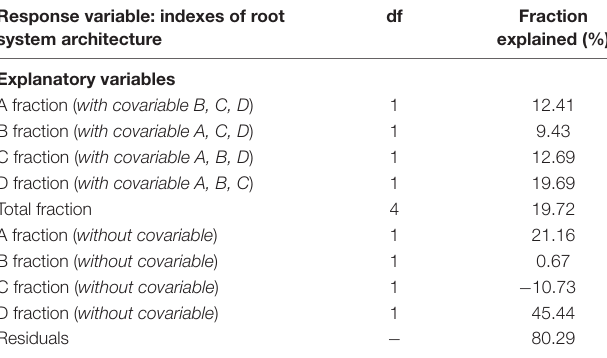
TABLE 5 | The effects of explanatory variables on the indexes of root system architecture of tea plant cutting seedlings via variation partitioning analysis. Response variable: indexes of root system architecture